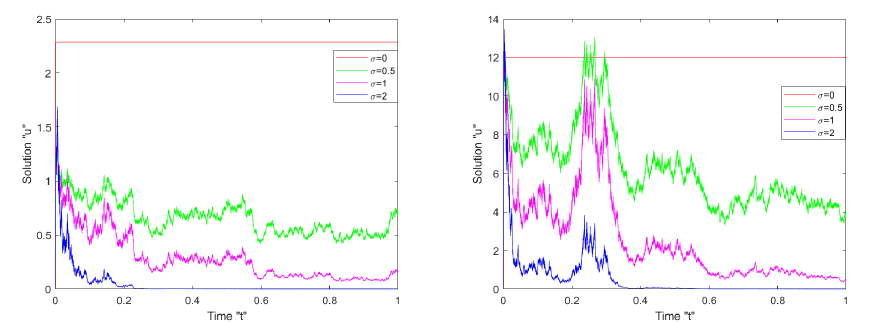
Figure 4. Two-dimensional plot of the solution of Equations (27) and (39) for different σ = 0, 0.5, 1,